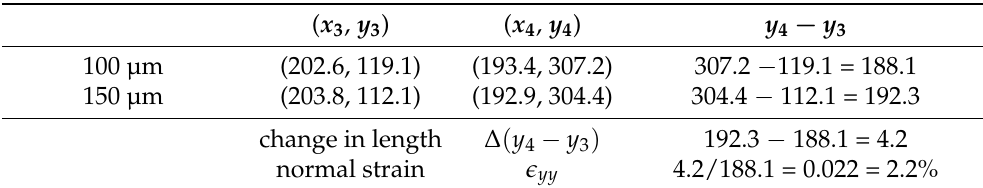
Table 3. Vertical normal strain estimated from representative